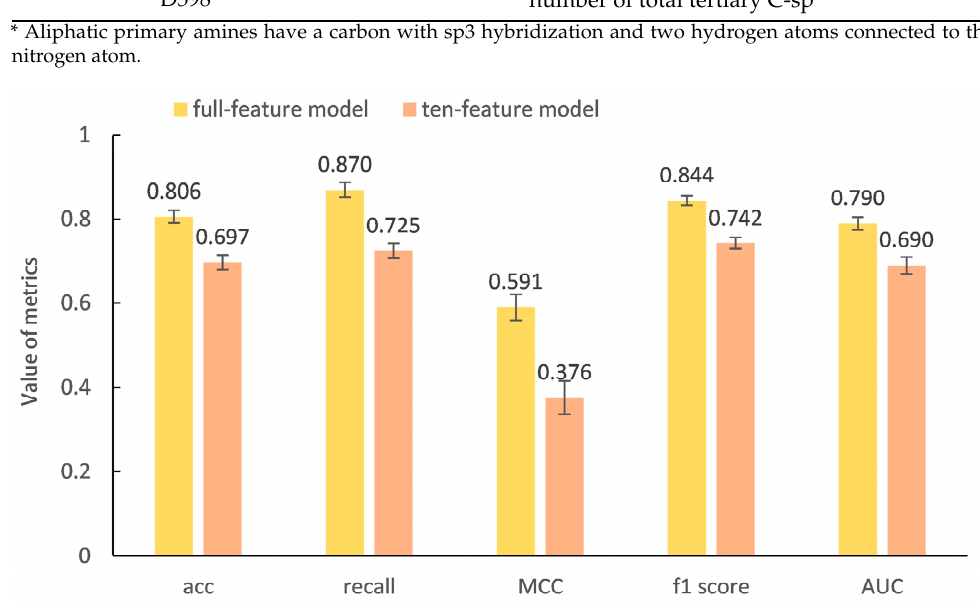
Figure 3. The predictive results achieved by SVM model with full features and ten features related to the 24 structural alerts.